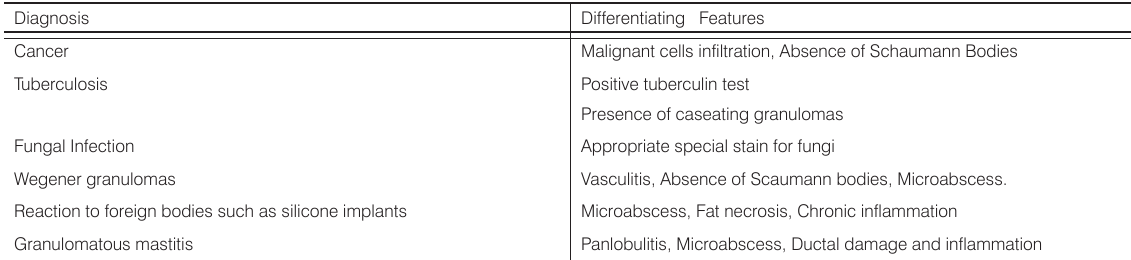
Table 1. Differential diagnosis of sarcoidosis from other pathological